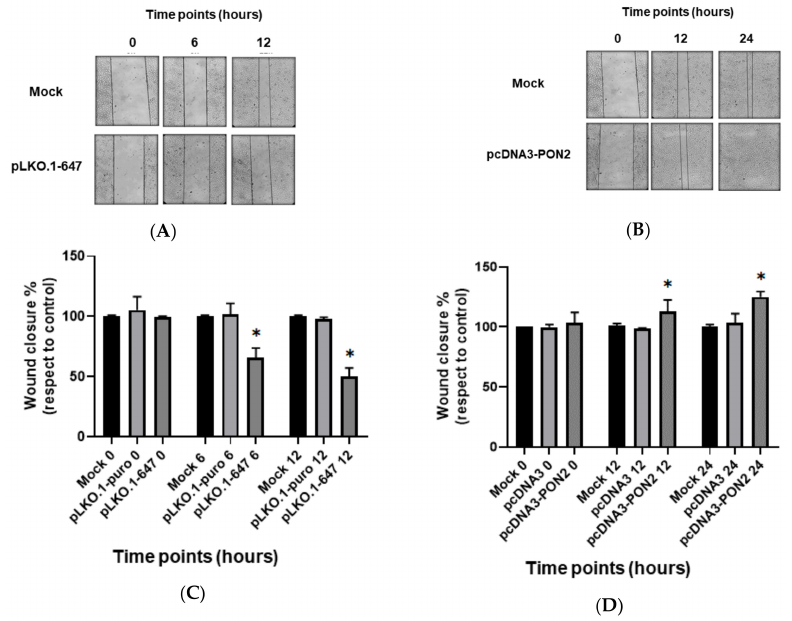
Figure 3. Migration ability of T24 cells. Wound healing assays were used to assess the impact of PON2 expression on cell migration. T24 cells transfected with the plasmid aimed to induce enzyme knockdown (panel A ) or overexpression (panel B ) were photographed immediately (0 h) after wounding by a pipette tip and at different time points, ranging between 6 and 24 h. The migration ability of T24 cells down- (panel C ) or upregulating PON2 (panel D ) was evaluated by measuring their efficiency in wound repair compared with that of mock samples. All values are expressed as the mean ± standard deviation (* p <